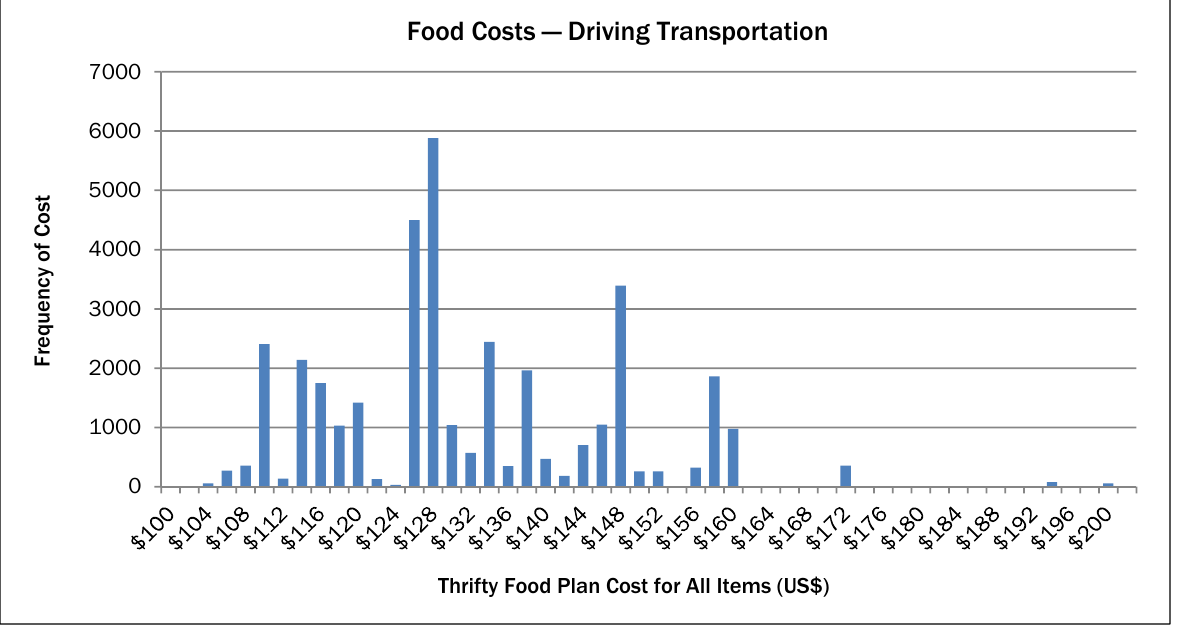
Figure 6. Variation in total cost of the USDA Thrifty Food Plan for the food items alone in the Gulf Coast counties of Mississippi, during spring 2011, assuming that all items are purchased and the shopper uses stores that provide the lowest cost combination of food price and transportation cost by automobile.